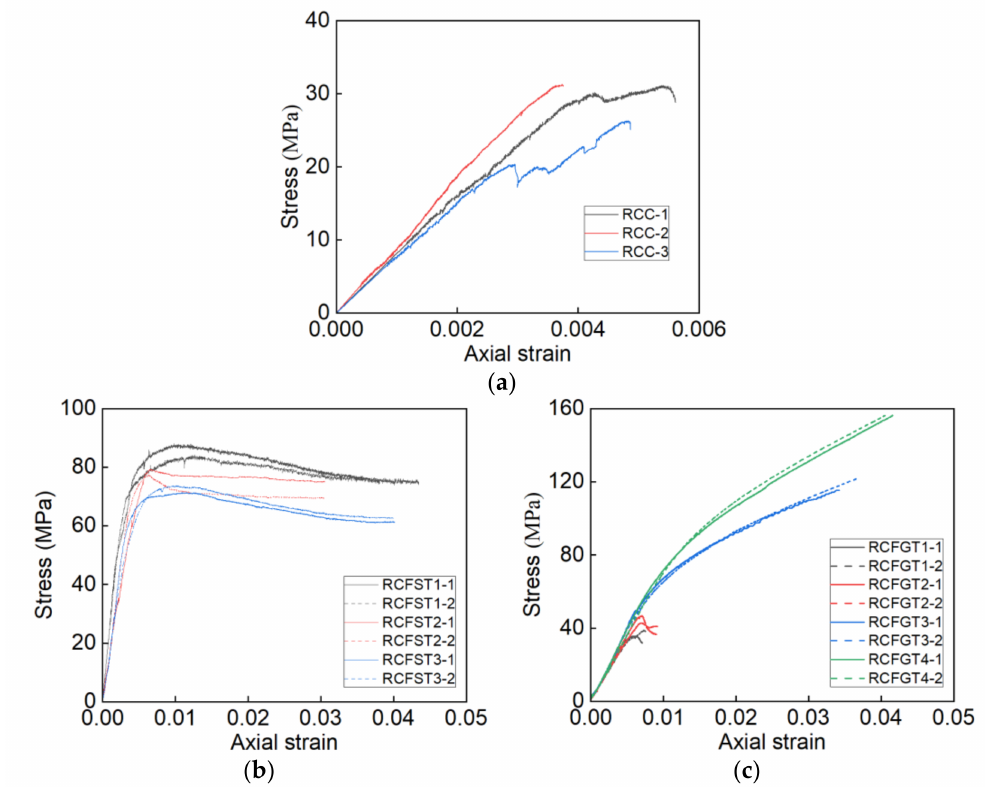
Figure 13. The stress-strain curves. ( a ) RAC; ( b ) core RAC in steel tubes; ( c ) core RAC in GFRP